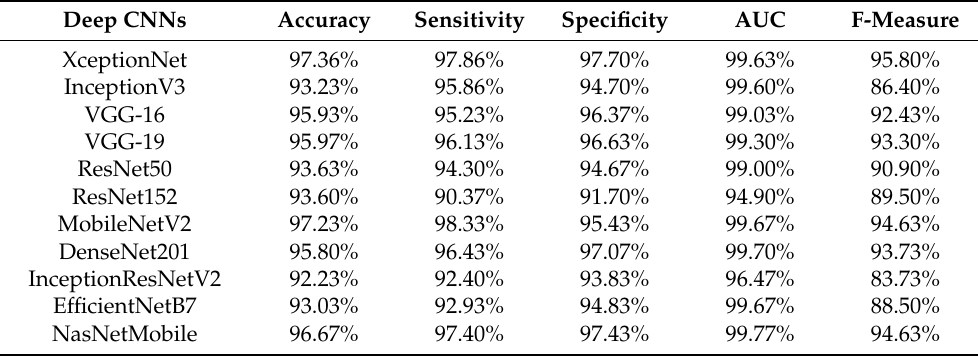
Table 9. Classification results of normal, pneumonia and COVID-19 using the cropped lungs and 11 CNNs with Hybrid sampling (Approach 5).